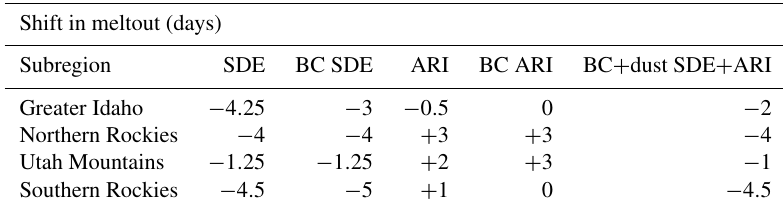
Table 5. Shifts in meltout date due to explicitly simulated effects